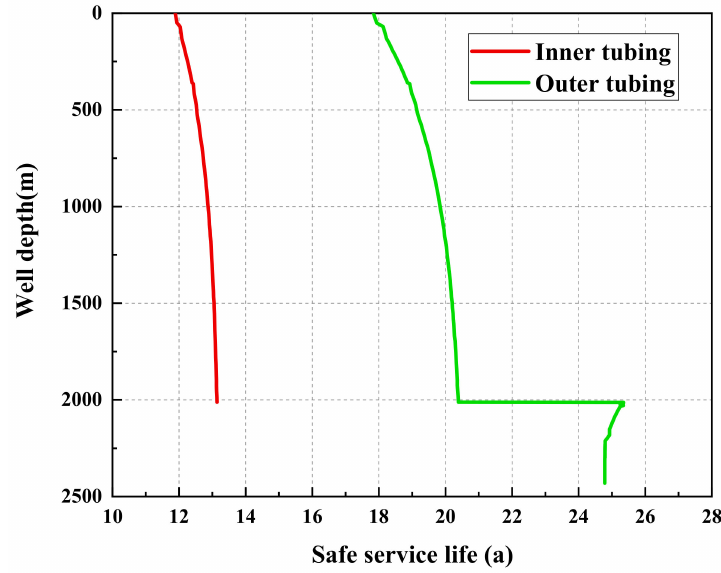
Figure 13. Corrosion life distribution of insulated tubing under uniform corrosion.